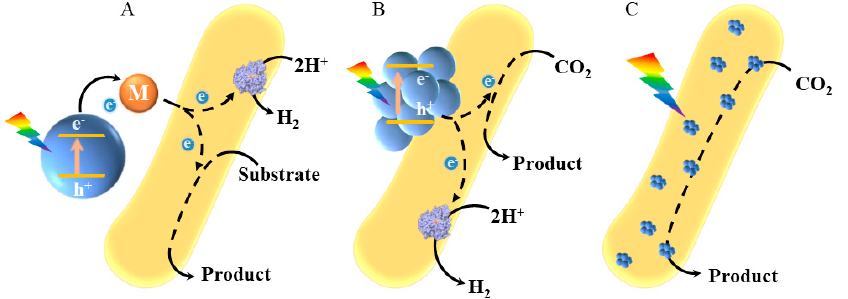
Figure 1. In material-microbe hybrids, the material can be distributed outside the cell. ( A ) On the cell membrane; ( B ) Inside the cell; ( C ) The photogenerated electrons generated by the material will enter the microbial cell that supplies energy for intracellular metabolism.